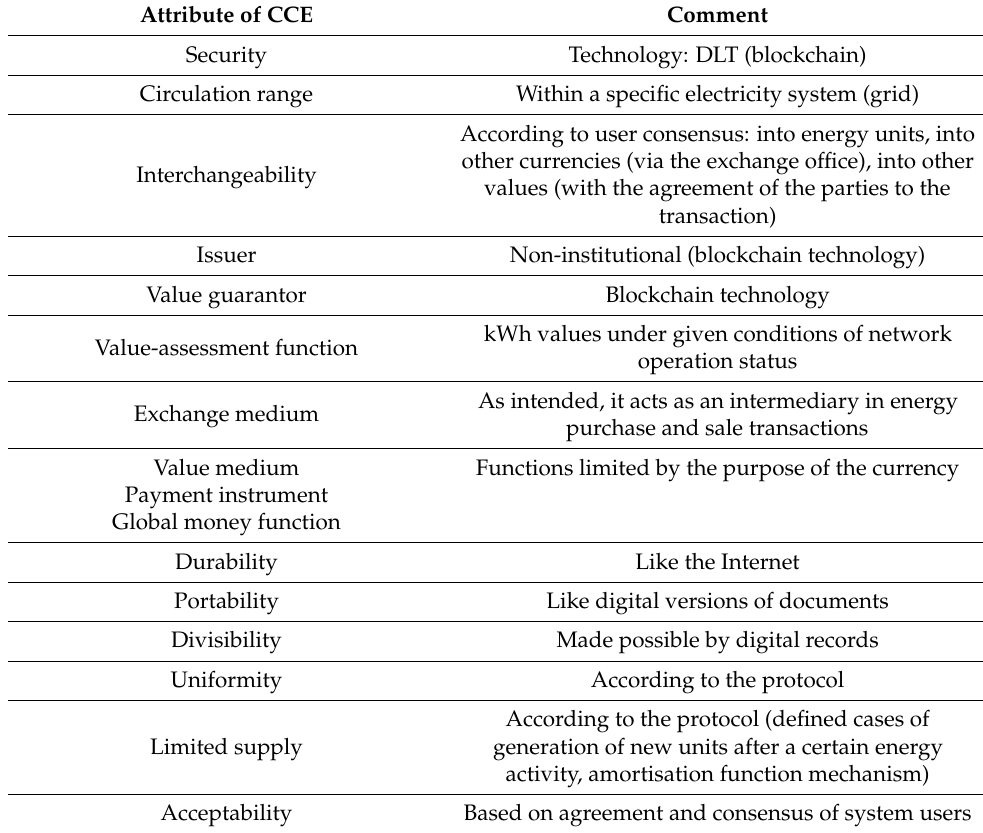
Table 3. CCE as a form of